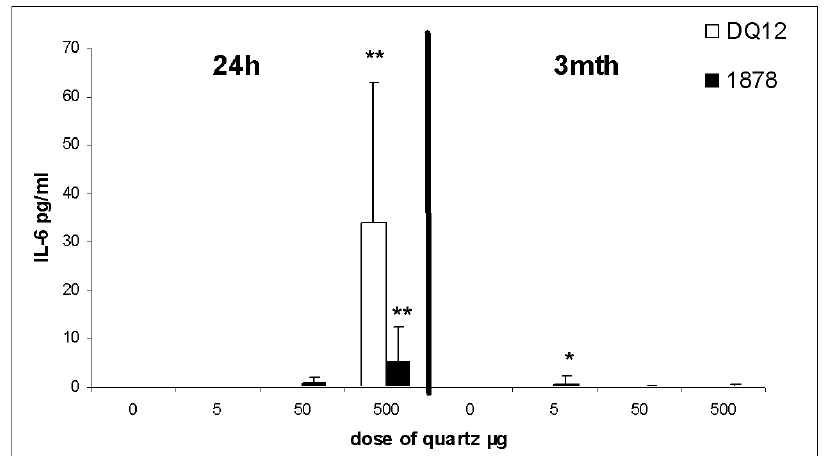
FIGURE 5. Quartz - IL-6 in BALF. The levels of IL-6 in BALF are shown as the median and 75 th percentile for DQ12 (white) and SRM1878a (black). BALF was collected 24 h or 3 months postinstillation in BALB/c mice. For explanation of statistical test results (* and **), see Statistics. Each group contained eight mice.